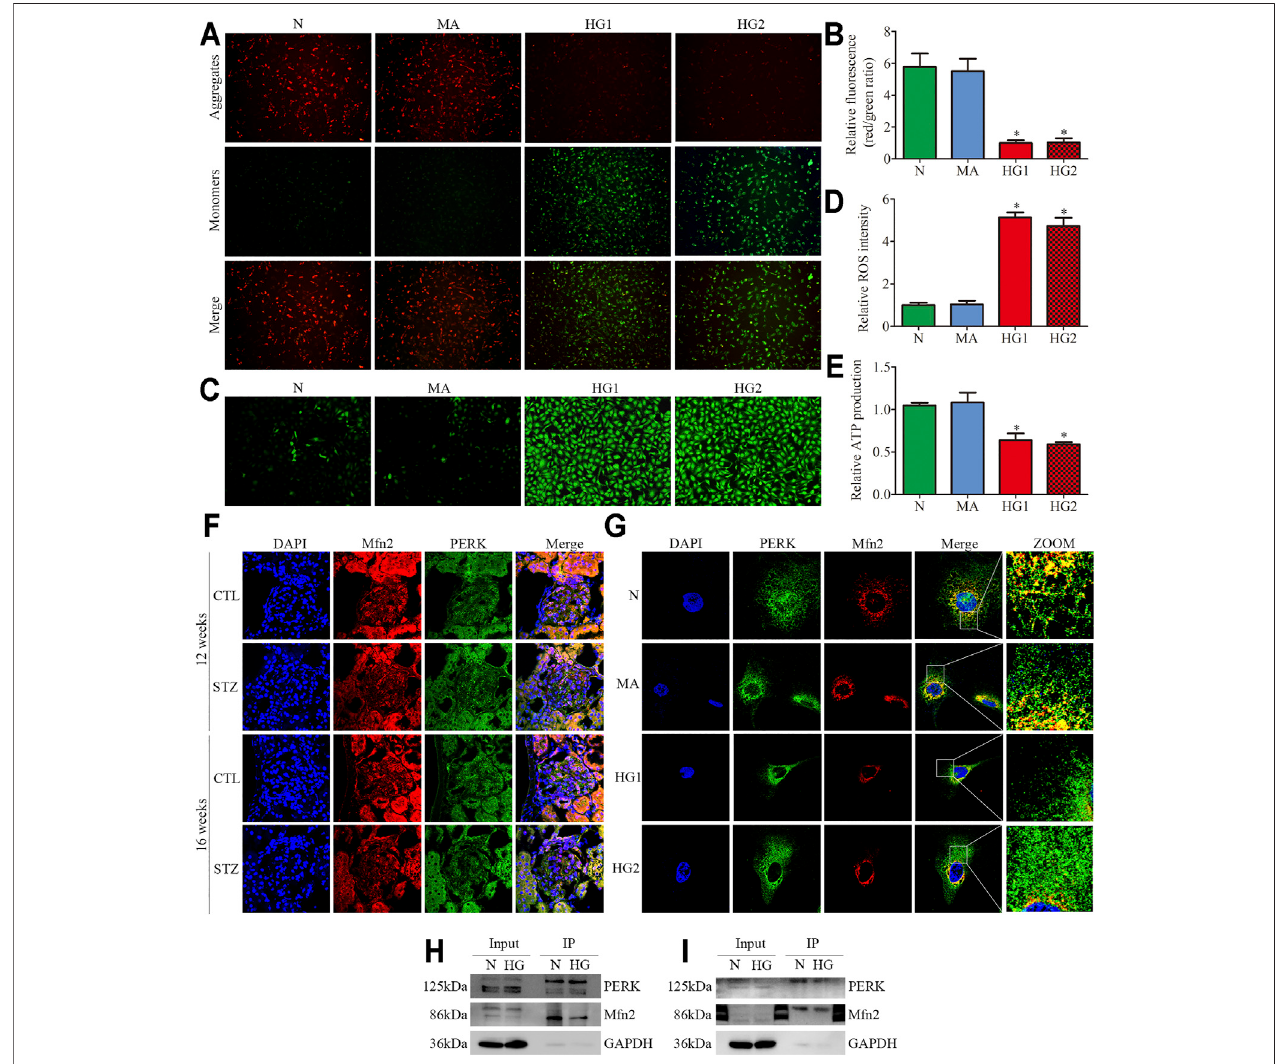
FIGURE5| MitochondrialfunctionsandMfn2-PERKinteractioninglomerulifromdiabeticratsandHG-treatedculturedpodocytes. (A,B) Representativeimagesof MMP in cultured podocytes by JC-1 staining and quanti fi cation per group (n (cid:1) 3) (original magni fi cation, × 100). (C,D) Representative images of DCFH-DA fl uorescence (green) in cultured podocytes to assess ROS production and quanti fi cation per group (n (cid:1) 3) (original magni fi cation, × 100). (E) ATP production was assessed and quanti fi cation per group (n (cid:1) 3). (F,G) Representative images of immuno fl uorescent staining of Mfn2, PERK and DAPI in glomeruli and cultured podocytes per group (original magni fi cation, × 600, × 1,000). (H,I) Representative coimmunoprecipitation results of the interaction between Mfn2 and PERK per group (H or I) Podocyte lysates were subjected to immunoprecipitation with PERK or Mfn2 antibody then the immunoprecipitates were blotted with Mfn2 or PERK antibody. CTL, control; DKD, diabetic kidney disease; N (cid:1) 5 mM glucose for 24 h; MA (cid:1) 5 mM glucose+20 mM mannitol for 24 h; HG1 and HG2 (cid:1) 25 mM glucose for 24 and 36 h; HG (Co-IP) (cid:1) 25 mM glucose for 24 h; * p < 0.05 compared with podocytes cultured in normal conditions.